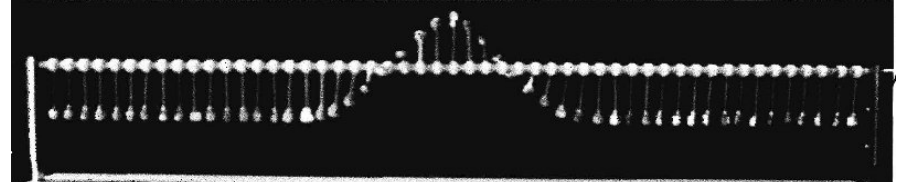
Figure 11. Mechanical model of the Frenkel–Kontorova